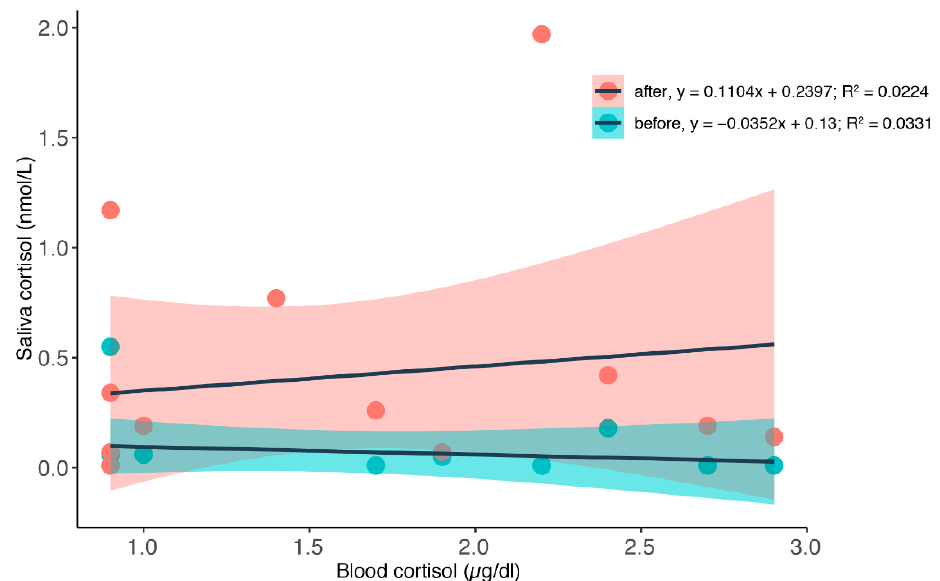
Figure 6. Correlation between blood cortisol values and saliva values during restriction. A linear curve was fitted (see Figures A3 and A4 for other curves). Saliva samples were taken before (green dots) and after (red dots) the blood samples; see Figure 3 for an exemplarily sampling scheme. Three dolphins were sampled (Jenny = 9 samples; Moby = 1 sample; Anke = 1 sample; Nami = 2 samples before, 3 samples after).